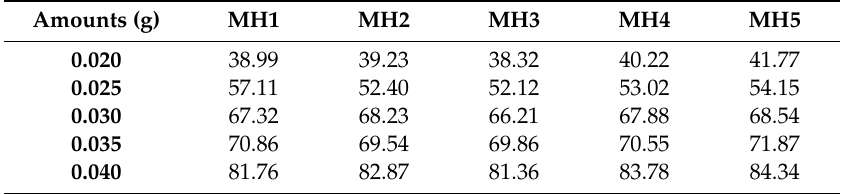
Table 6. Photocatalytic degradation of alizarin red (AR) dye (250 ppm) by di ff erent catalytic dosage of MH1–MH5 after 60 min of photocatalytic activity.